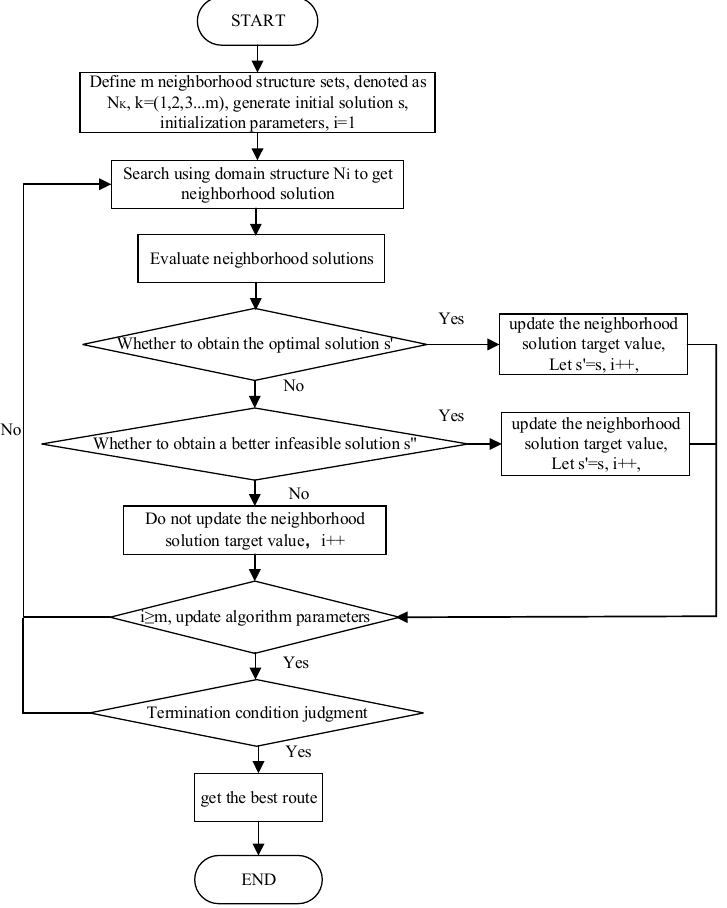
Figure 6. Algorithm flow chart.